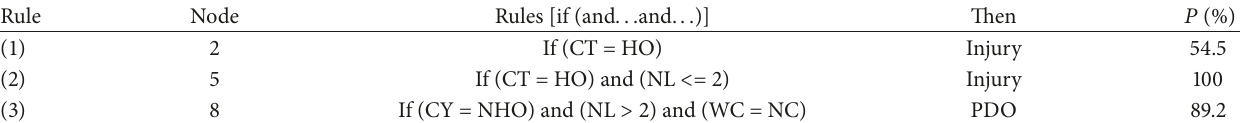
Table 3: Decision rules for crash severity of dark-lighted condition.